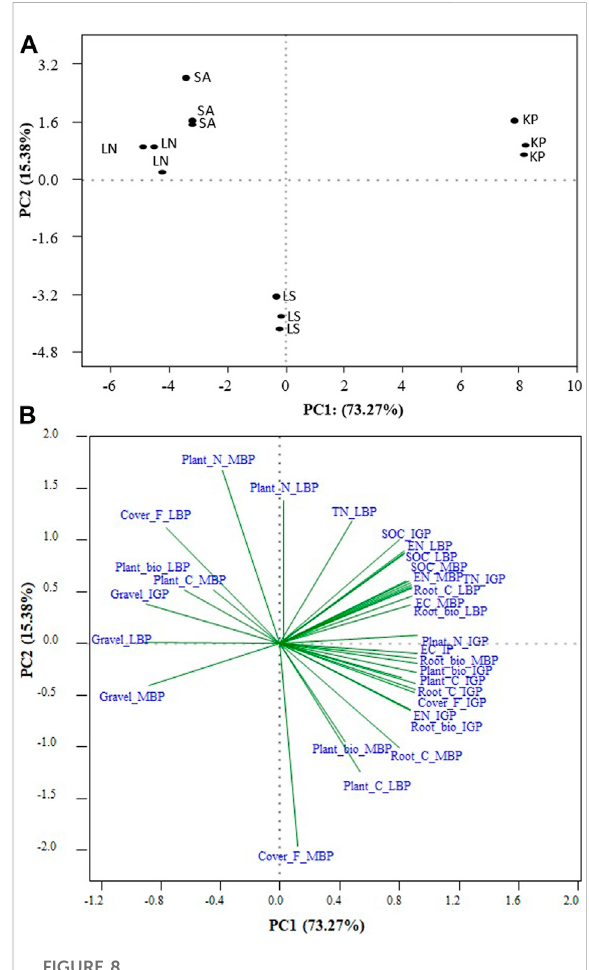
FIGURE 8 Principal component analysis (A) score plot and (B) biplot based on theeffect of grassland patchiness on ecosystem C and N storage in four typical alpine grass species patches. KP; Koeleria pers patch, SA; Stipa aliena patch, LN; Leontpodium nanum patch, LS; Leymus secalinus patch. Cover F LBP; cover fraction in large stripped patch, Cover F IGP; cover fraction in intact grass patch,CoverFMBP;coverfractioninmediumstrippedpatch,SOC IGP; soil organic carbon in intact grass patch, SOC LBP; soil organic carbon in large stripped patch, Plant bio IGP; plant biomass in intact grass patch, Plant N IGP; plant nitrogen in intact grass patch, EN IGP; ecosystem nitrogen in intact grass